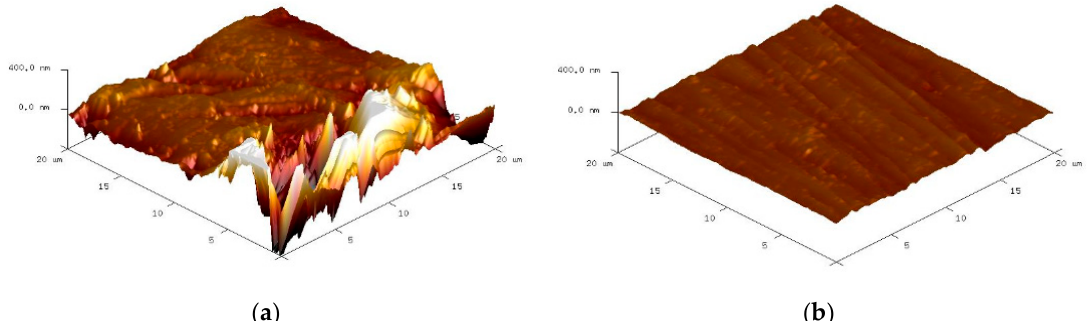
Figure 9. Atomic Force Microscope (AFM) images of the surfaces before and after being machined by